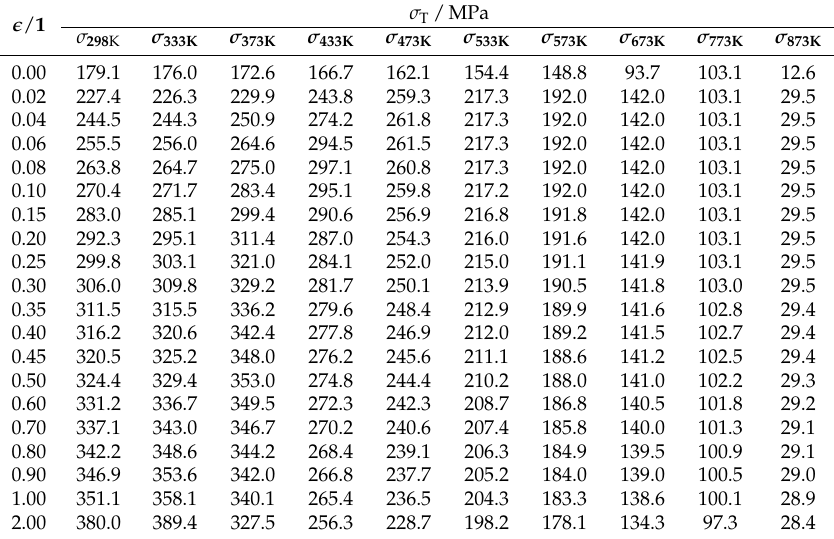
Table A5. Flow Stress of EN-AW-5083.